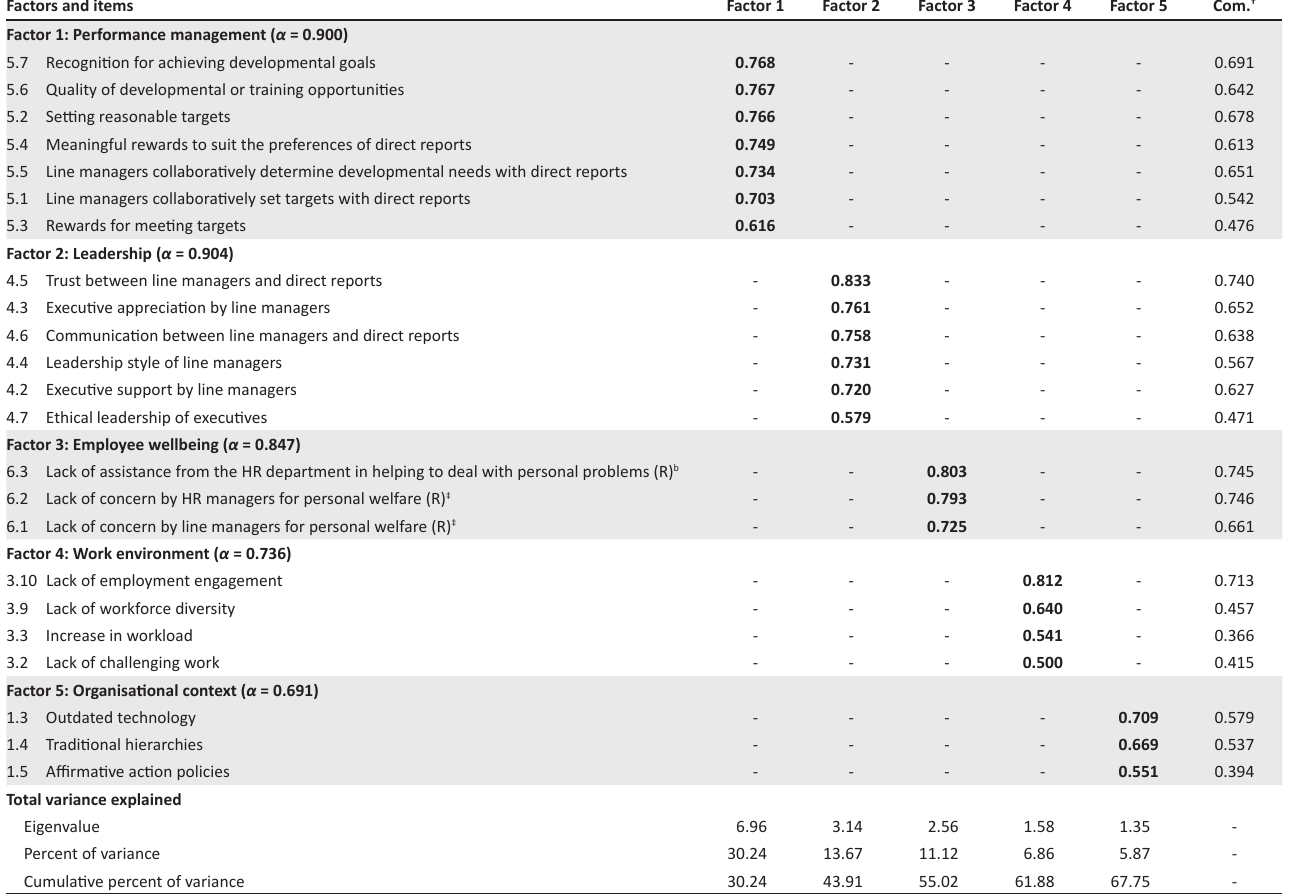
TABLE 1: Factor loadings for Varimax with Kaiser Normalisation five-factor solution. Factors and